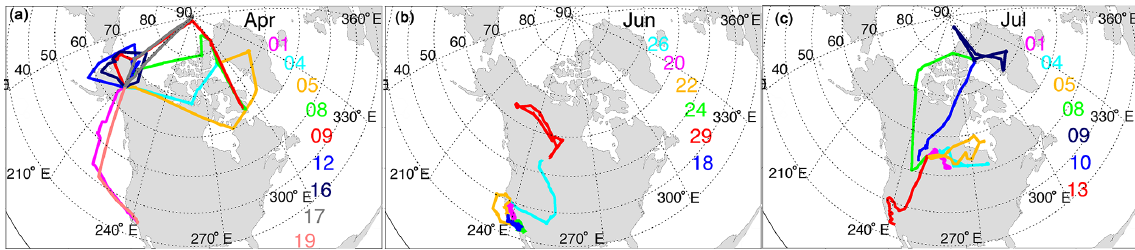
Figure 2. Flight tracks of ARCTAS-A (a) , ARCTAS-CARB (b) , and ARCTAS-B (c) . The colors represent observations during different